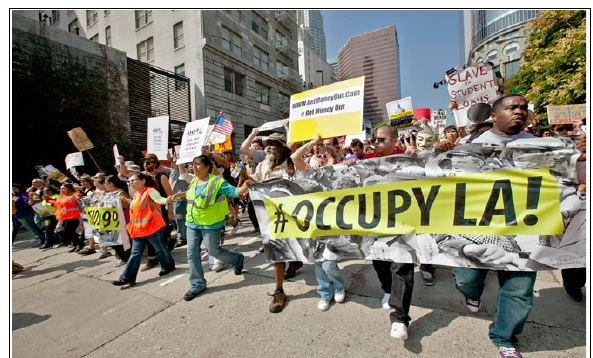
Figure 1. Occupy Movement protest in Los Angeles